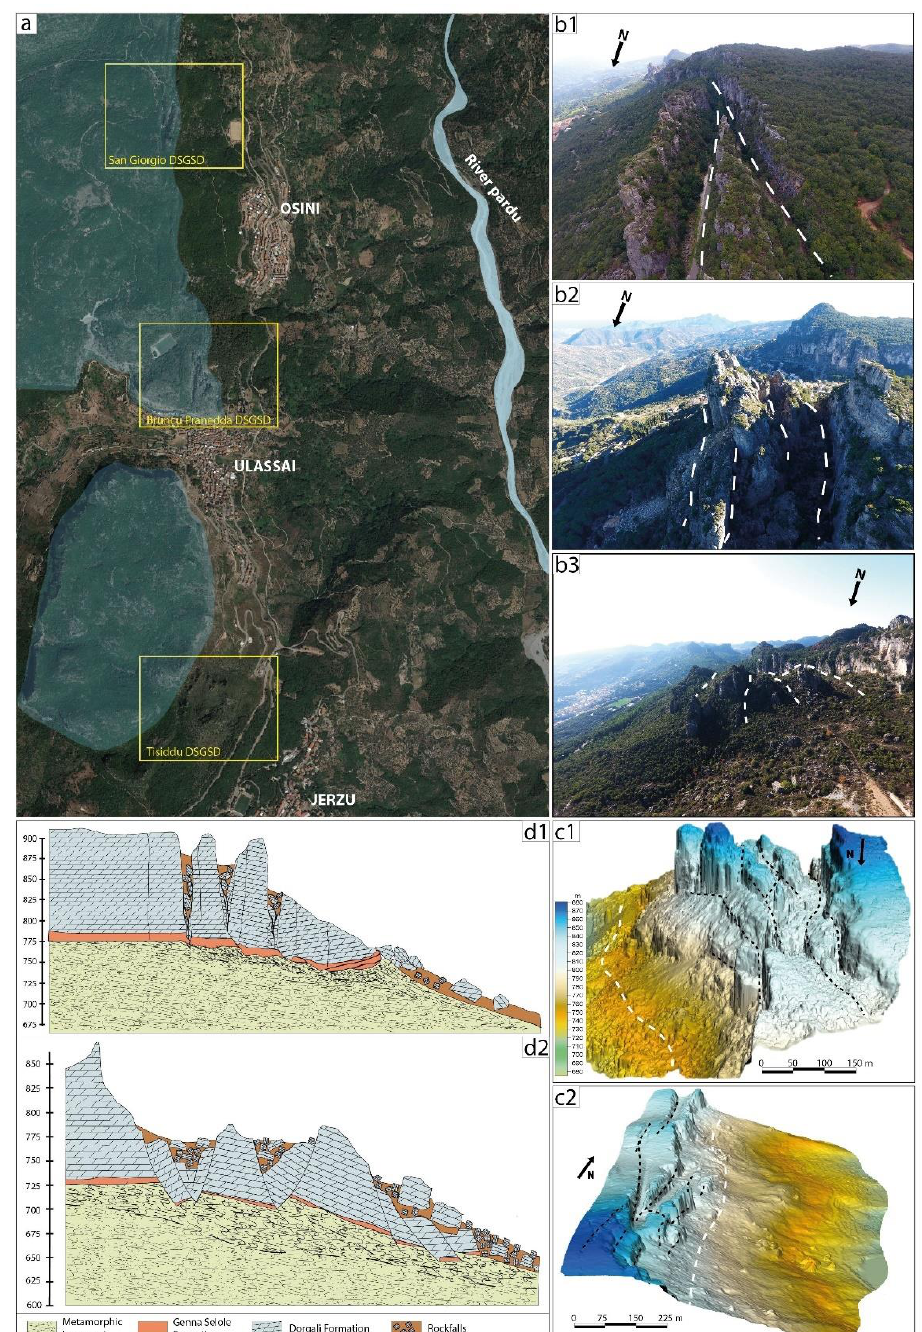
Figure 7. DGSD on the right slope of the Pardu River. ( a ) Orthophoto of the area of Ulassai, Osini, and Jerzu. The Jurassic dolostone plateaus on the metamorphic basement are shown in blue. The yellow square represents the analyzed DGSD. ( b ) UAV images of the DGSD showing the major geomorphological and structural features. The white dashed lines rep- resent the major extensional trenches. ( b1 ) San Giorgio lateral spread, ( b2 ) Bruncu Pranedda lateral spread, ( b3 ) Monte Tisiddu sackung. ( c ) Three-dimensional LiDAR model of the DGSDs with a colored elevation scale. The black dashed lines represent the major extensional trenches. The white dashed lines represent the major stratigraphic discontinuity between the marine Mesozoic sequence and the metamorphic basement. ( c1 ) Bruncu Pranedda lateral spread. ( c2 ) San Giorgio lateral spread. ( d ) Interpretative geological cross-sections passing through the DGSD in the study area. The hypothetical basal shear zone is highlighted with black dotted lines. ( d1 ) San Giorgio lateral spread. ( d2 ) Monte Tisiddu sackung.